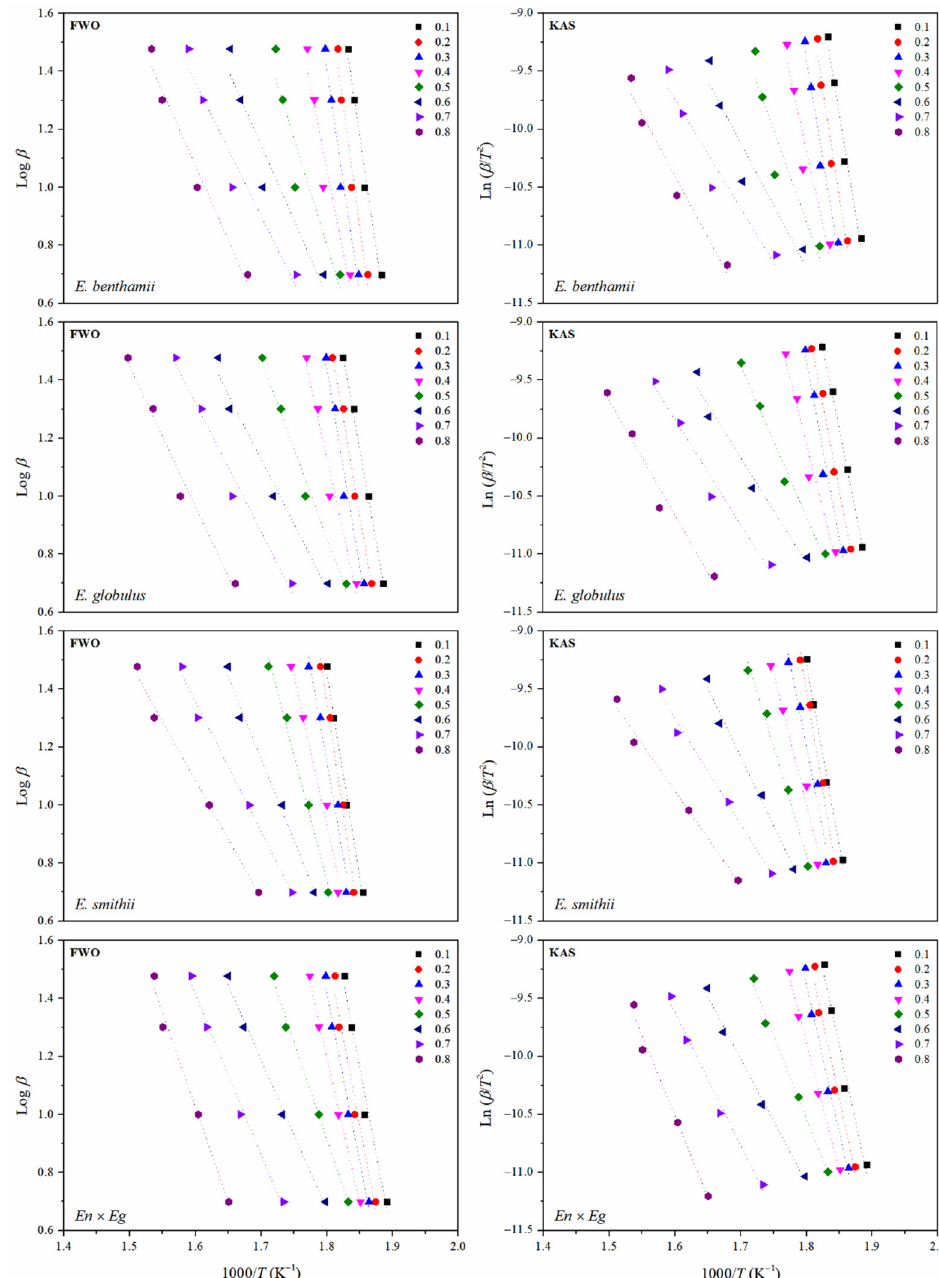
Figure 8. Application of Flynn–Wall–Ozawa (FWO) ( left ) and Kissinger–Akahira–Sunose (KAS) ( right ) methods for the CNCs obtained from the different eucalyptus species.